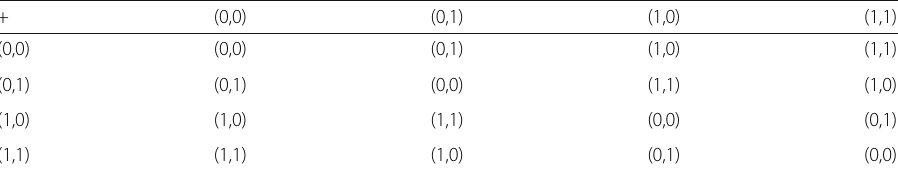
Table 4 Addition modulo 2 in the group ( H 2 × H 2 ,